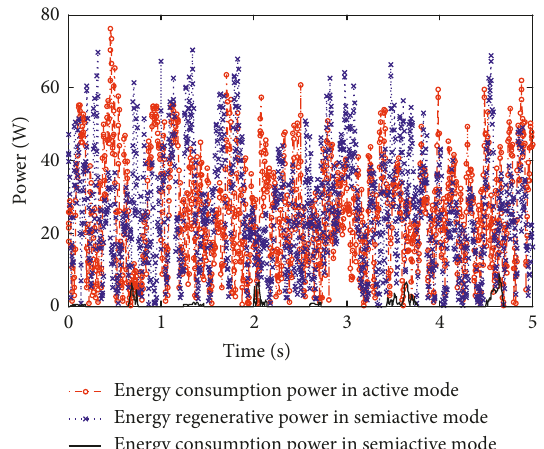
Figure 28: The energy consumption power and energy-re- generative power of the hybrid